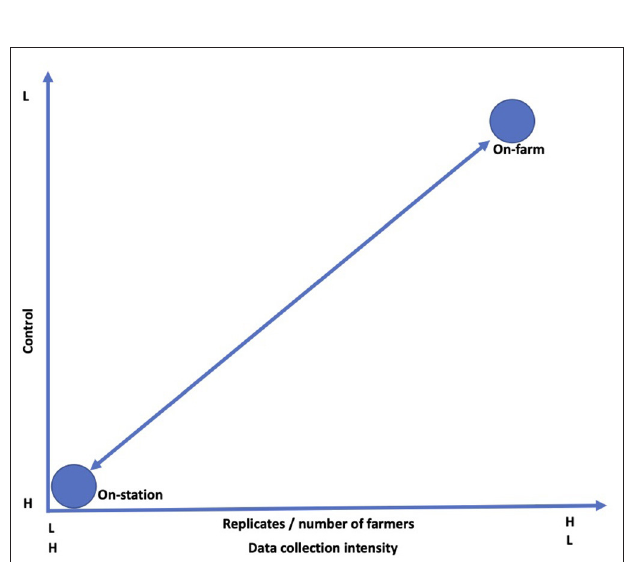
FIGURE 4 | A balance between cost and data collection must be considered for on-farm trial replicates for PAR-CSA in West Africa. High costs (green star) and low data intensity (red star) are to be avoided. A balance between the two must be struck (blue line) (H, High; L, Low) (Source: Bayala et al.,